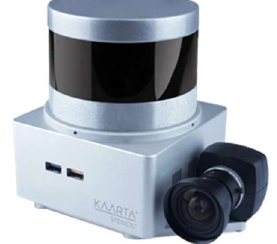
Figure 3. The KAARTA Stencil